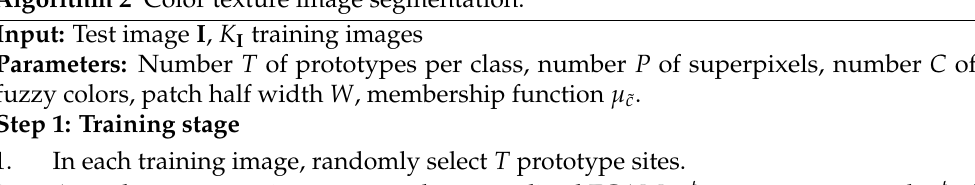
Figure 5. Flowchart of the proposed color texture image segmentation (SLIC: simple linear iterative clustering, FCAM: fuzzy color aura maxtrix, ELM: extreme learning machine). Algorithm 2 Color texture image